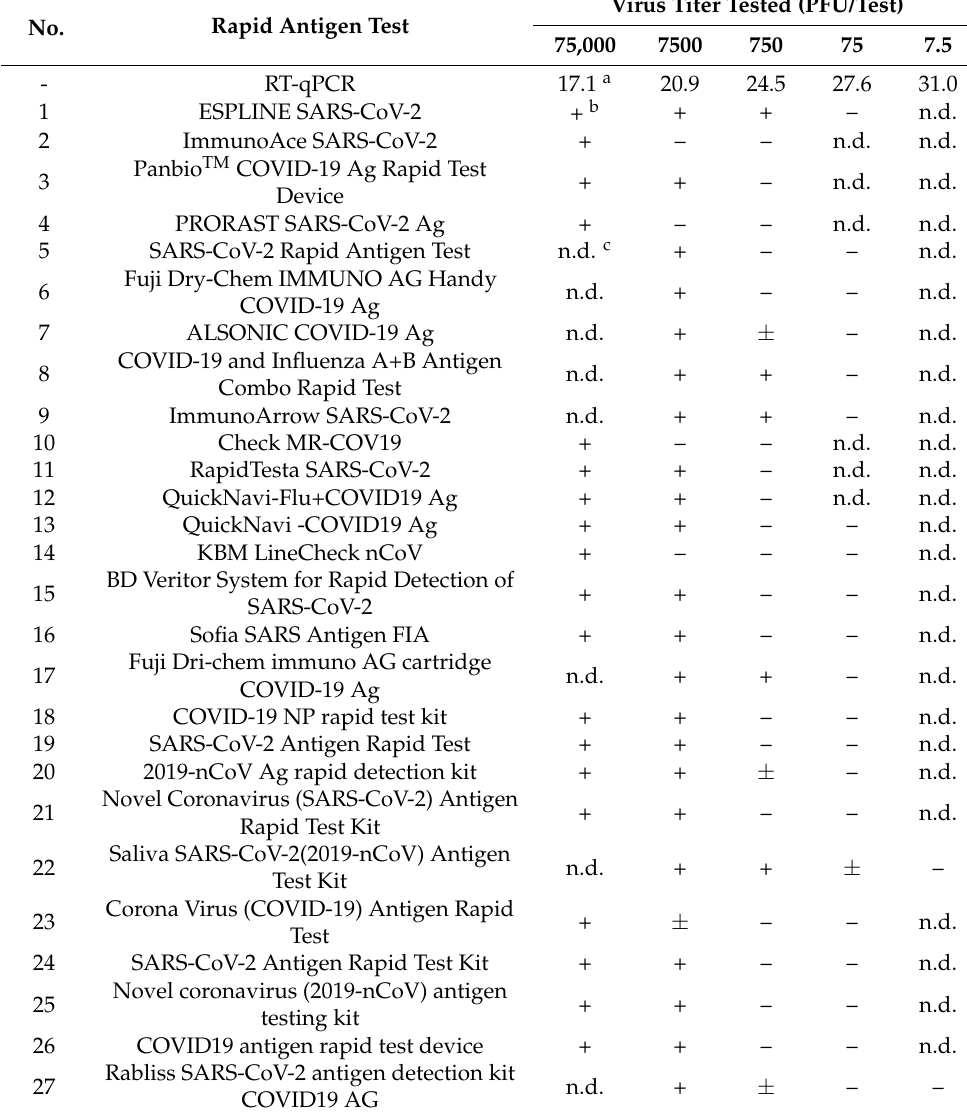
Table 3. Sensitivity of rapid antigen tests for the delta